Question: From the figure, is the trend upward or downward?
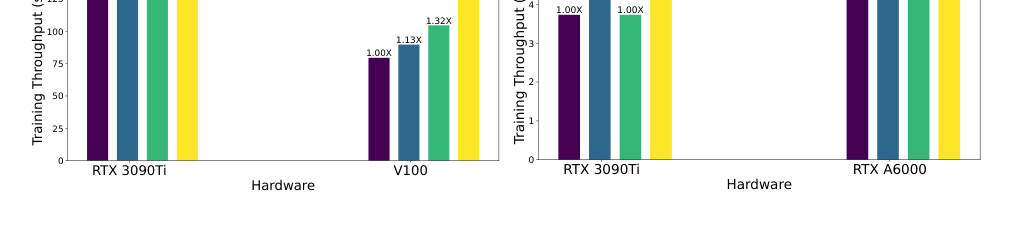
Answer: increasing